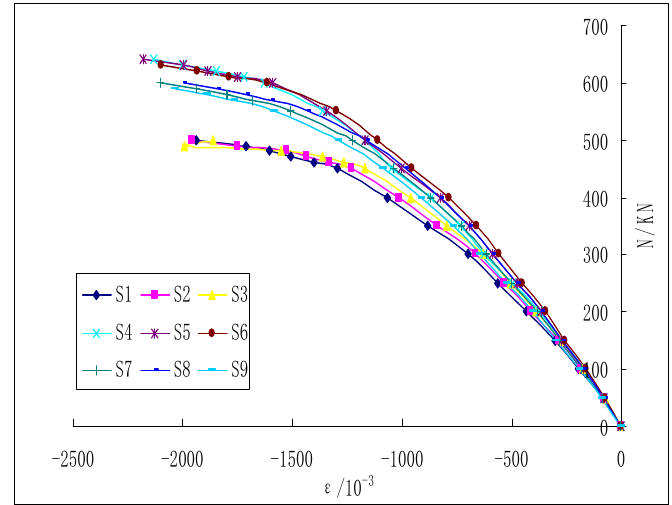
Figure 7. The average strain curve of the steel bars.